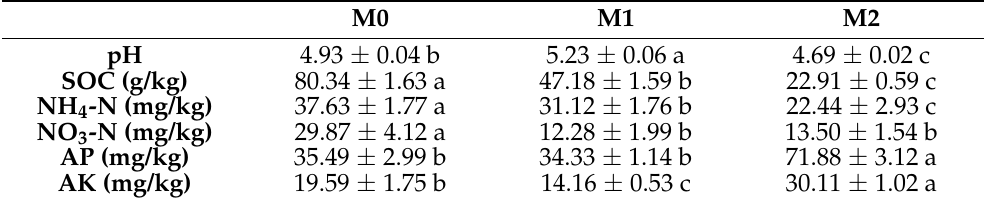
Table 1. Soil properties in bamboo soils from undisturbed (M0), extensively managed (M1), and intensively managed (M2)